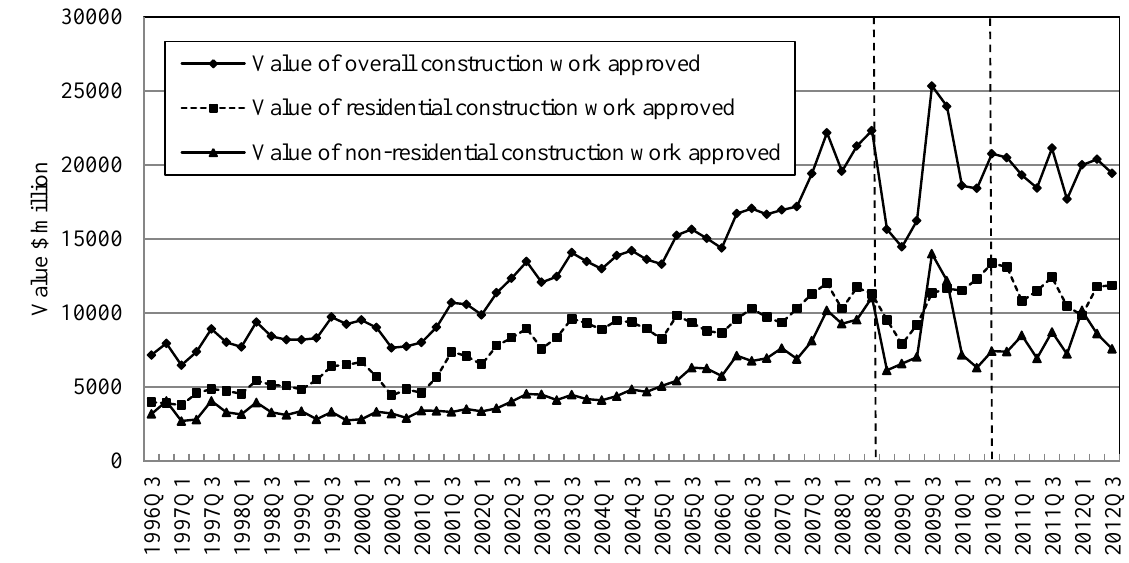
Figure 1 A plot of the time series for three types of the value of construction work approved (two vertical dot lines highlight the duration of the effect of the late 2000s financial crisis on the construction